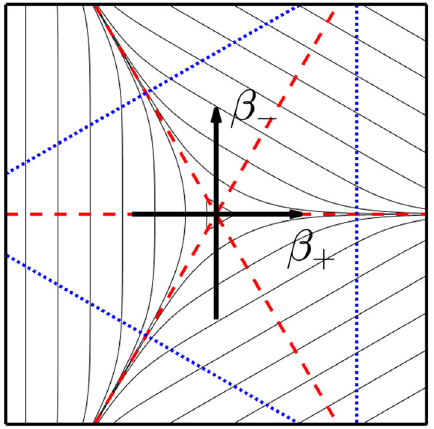
Fig. 1 Potential picture for the tumbling case. The black contour lines represent the curvature potential while the dotted (blue) and dashed (red) lines represent the rotation and centrifugal walls,